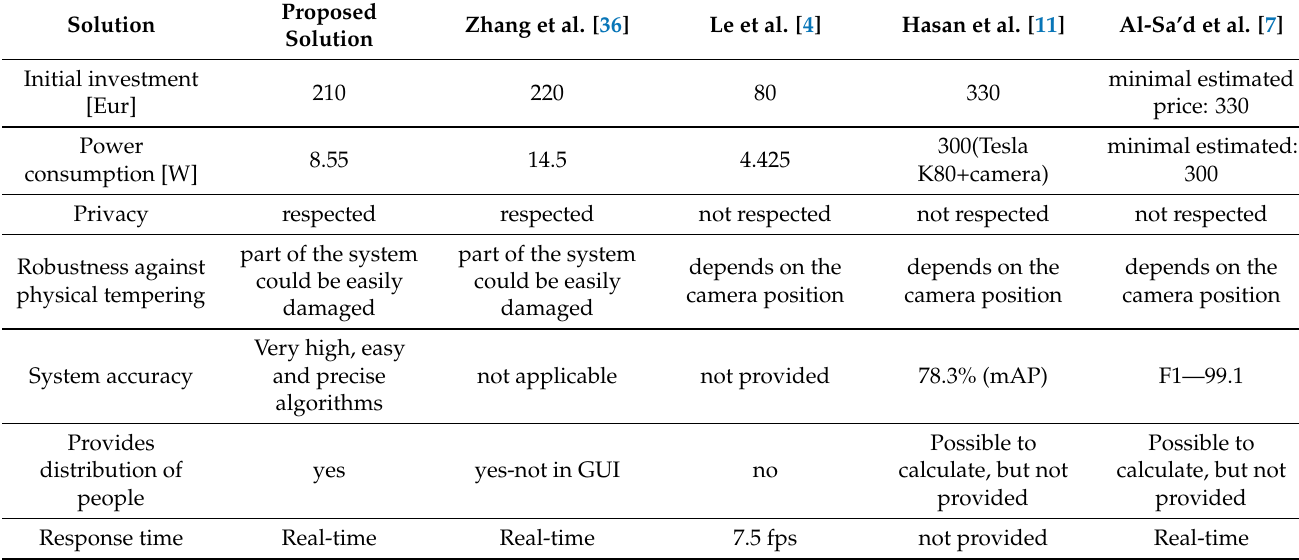
Table 4. Comparison of the proposed system with other